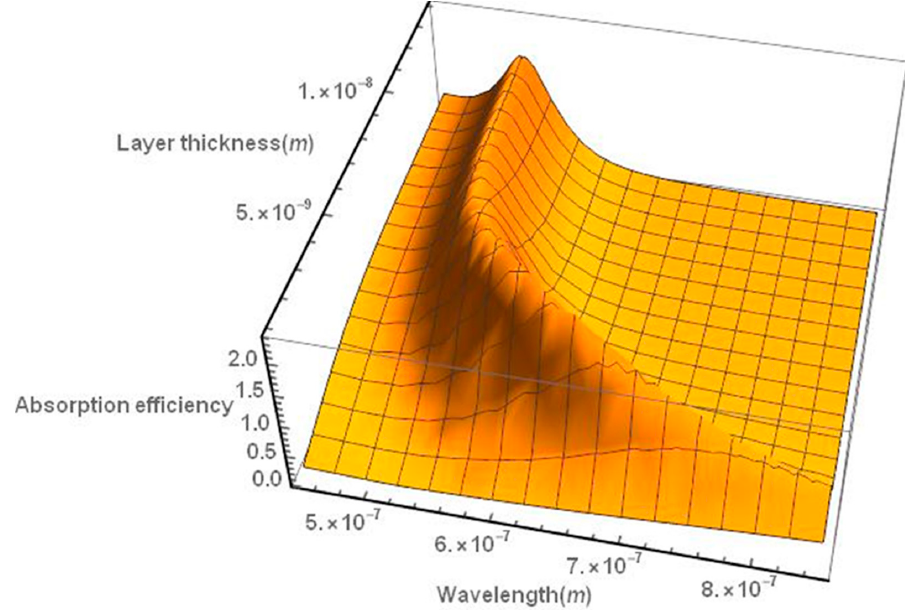
Figure 3. Absorption efficiency spectrum of a gold nanoshell as a function of the thickness of the